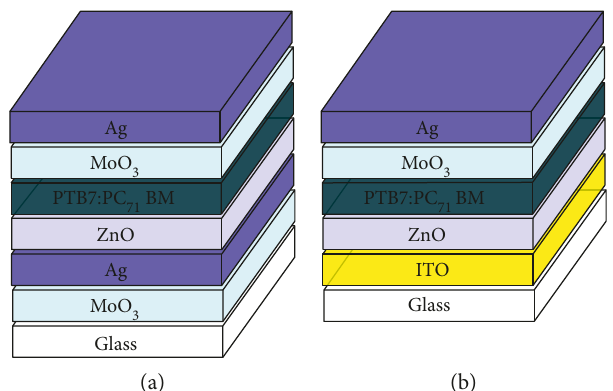
Figure 1: Schematic diagrams of inverted OSCs based on (a) the MoO